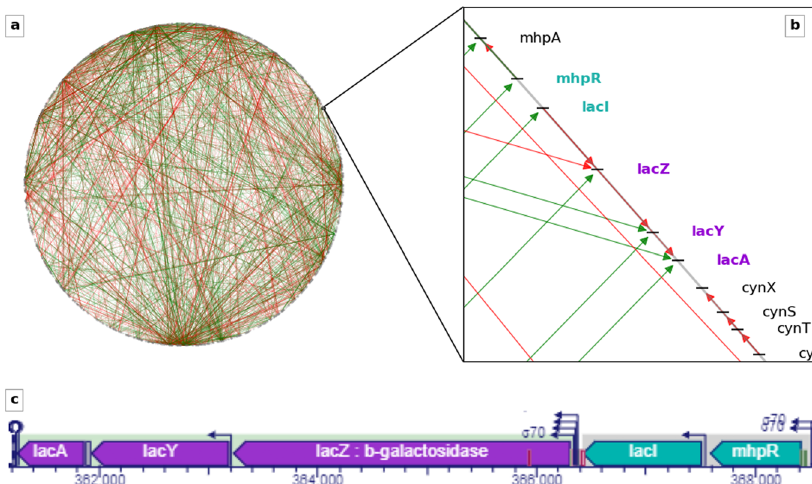
Fig. 1 Transcriptional regulatory network (TRN) of E. coli . a Via the chromosomal coordinates of each gene, the TRN can be represented as embedded in a circular space given by the bacterial chromosome. Nodes represent genes. Blue, red, grey directed edges from the regulator genes to the target genes represent the action of activating, repressing, dual/unknown transcription factors (TFs), respectively. b Magni fi ed view of one spatial region containing the operons lacZYA and mhpR-lacI (gene name colors represent operon membership). c Standard EcoCyc 50 visualisation of the operons highlighted in ( b